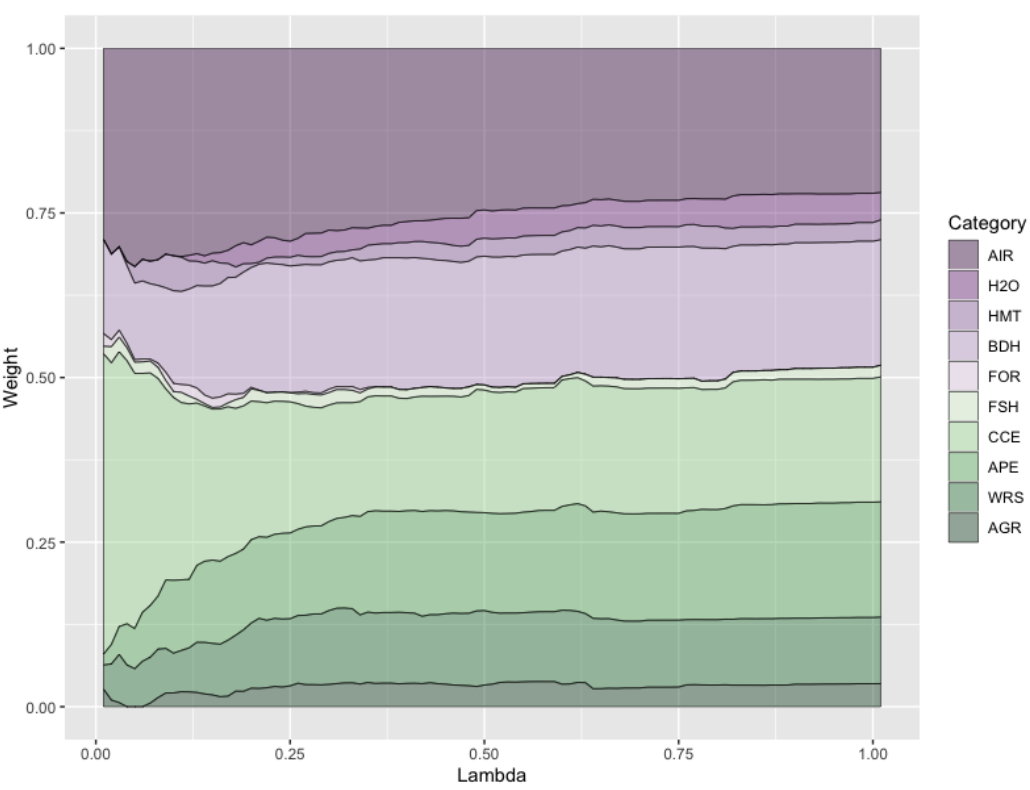
Figure 2. Aggregated weights for the issue categories of the environmental